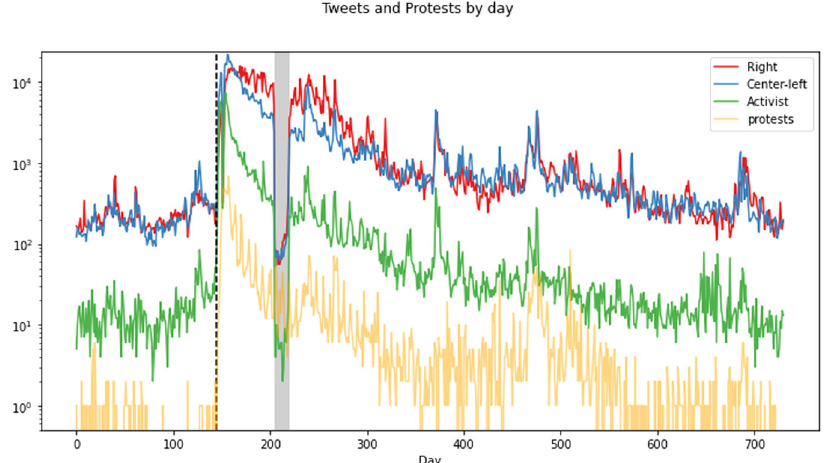
Fig. 2 Original tweets and protests. y -axis is on a log scale. Black dashed line shows the date of George Floyd's murder. Gray bar shows period of disrupted data